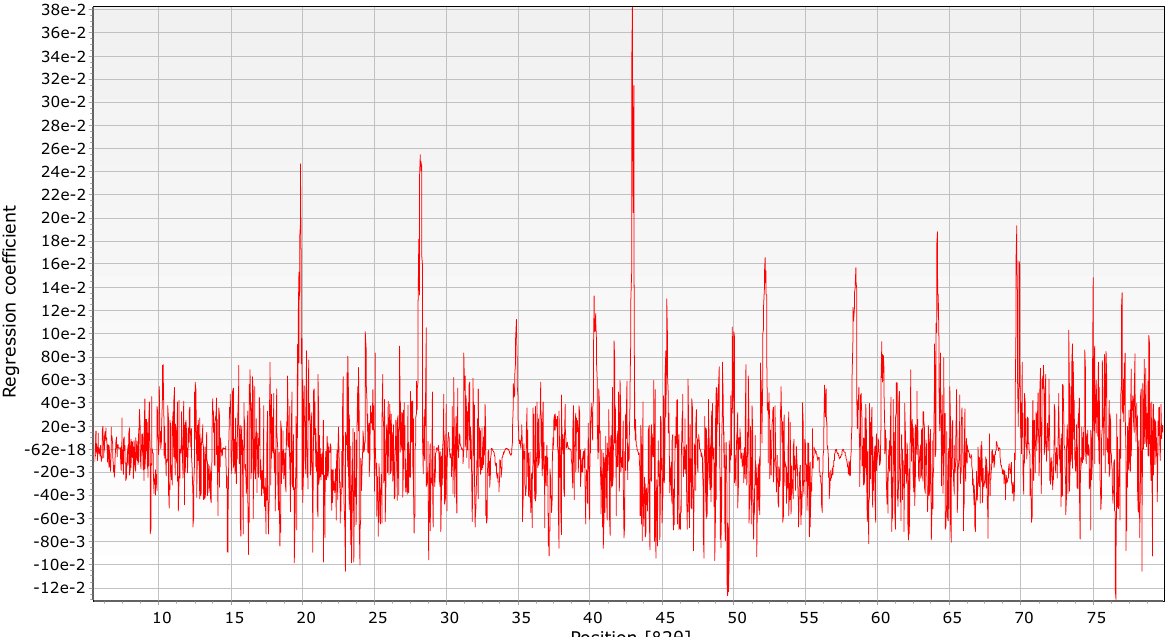
Figure 10. PLSR plot of predicted values and reference values of antimony concentration in copper concentrates. The plot contains both training and validation data of the model.